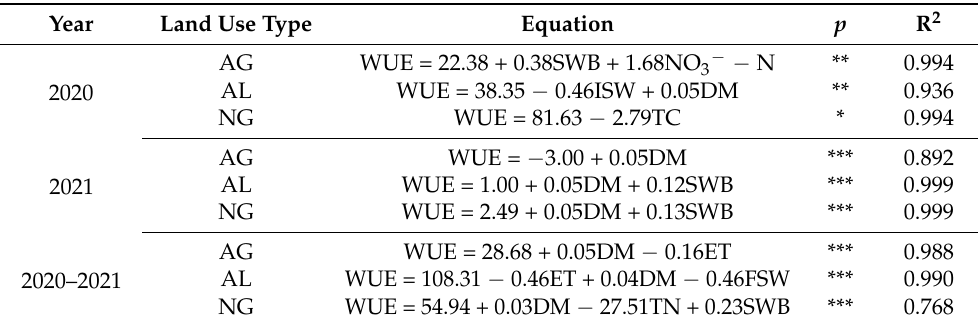
Figure 3. Water use efficiency of different land use types in 2020 and 2021. AG: artificial grassland; AL: cropland; NG: natural grassland; T: land use type; Y: year; T × Y: interaction of land use type and year. Lowercase letters indicate the significant difference between different land use type in the same year ( p < 0.05). The asterisk indicates a significant difference between two years for the same land use type. *, ***, ns represent p < 0.05, p < 0.001, p > 0.05, respectively. Data are shown as mean ± s.e.m. Table 3. Stepwise regression analysis of water use efficiency and soil physicochemical properties, dry matter accumulation and